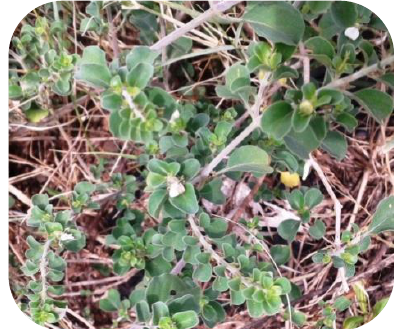
Figure 1. Leaves of Justicia tranquebariensis L.